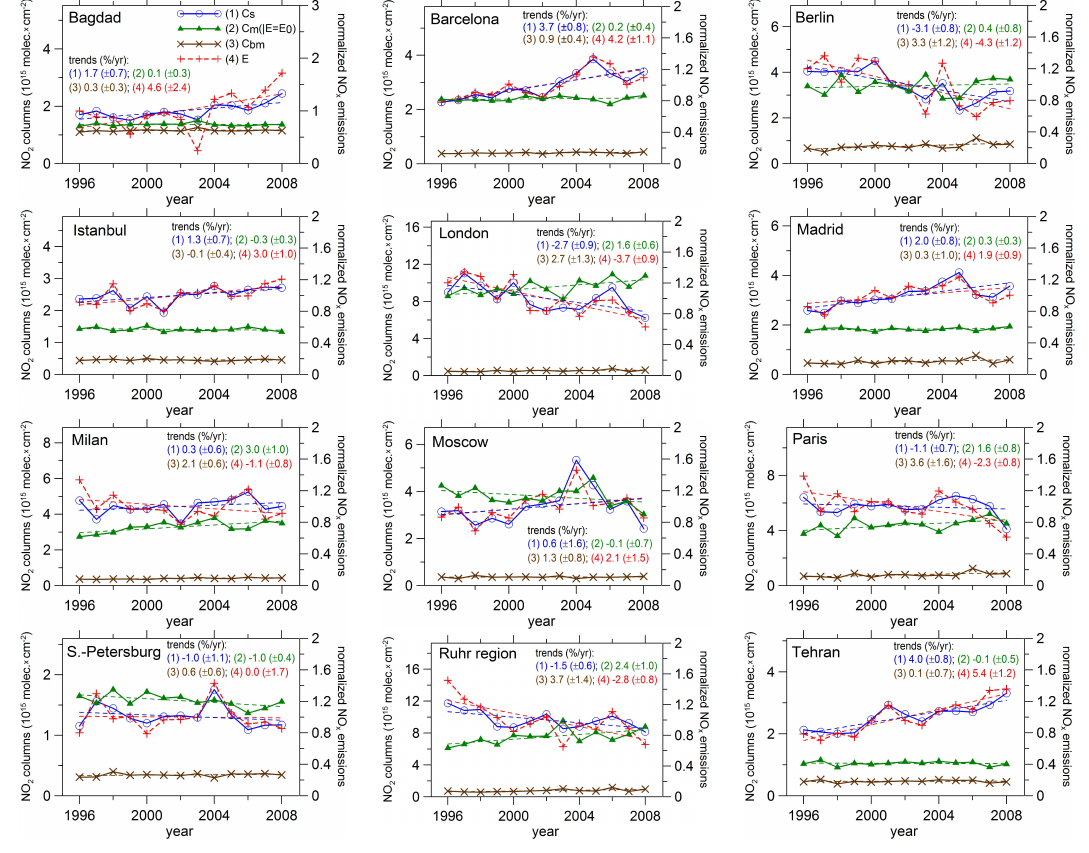
Fig. 4. The combined time series of satellite data (1 − C s ) for tropospheric NO 2 columns in comparison with the NO 2 columns simulated by CHIMERE with constant NO x emissions ( 2 − C m ) and with zero anthropogenic emissions (3 − C bm ). The time series of NO x emission estimates (4 − E ) are also shown. Magnitudes of slopes of linear fits are related to values of corresponding characteristics in 1996. Uncertainty range is given in terms of the 68.3 percentile (one sigma).